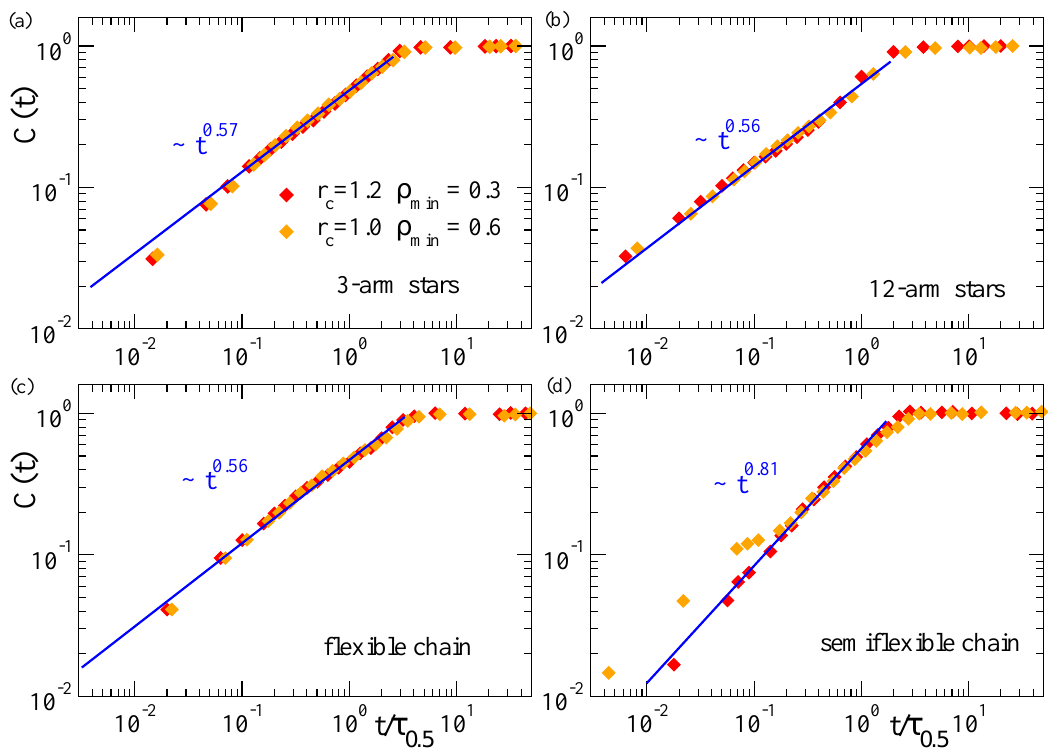
Figure 4. Relative domain size C ( t ) over time during the collapse at φ = 1.2 of three-arm stars ( a ), 12-arm stars ( b ), flexible chains ( c ) and semiflexible chains ( d ). Different datasets correspond to different values of the parameters r c and ρ min used to construct the density field. The time t is normalized by τ 0.5 , defined as in Figure 3. Straight lines in all panels fit to a power-law time dependence (exponents are